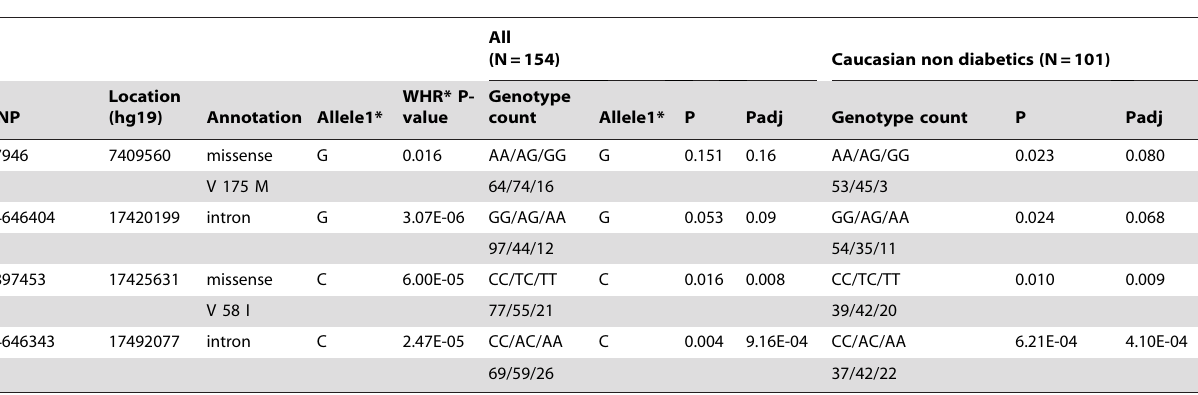
Table 3. WHR-associated SNPs in PEMT modulate its transcript level expression in subcutaneous adipose tissue.